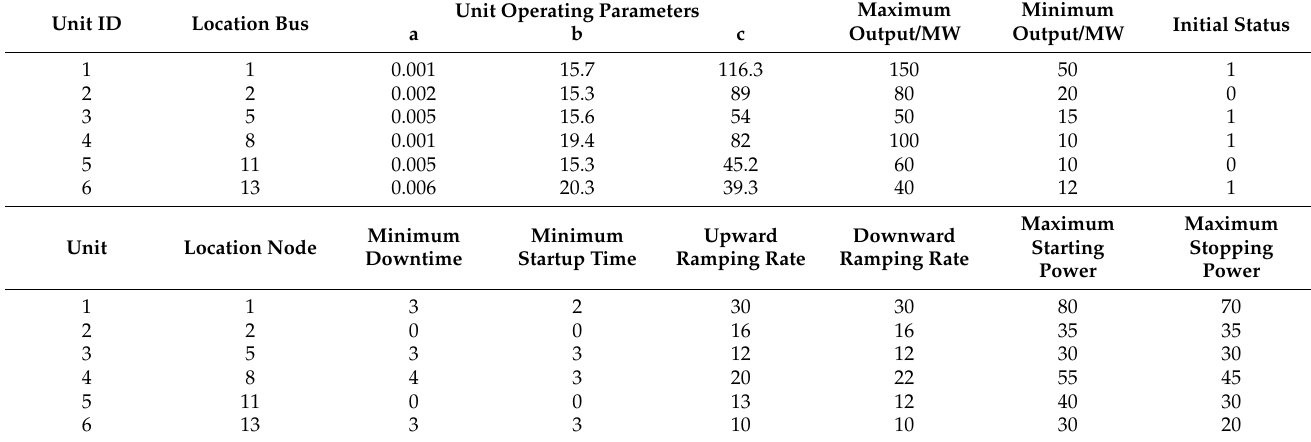
Table A2. Thermal power unit parameters.